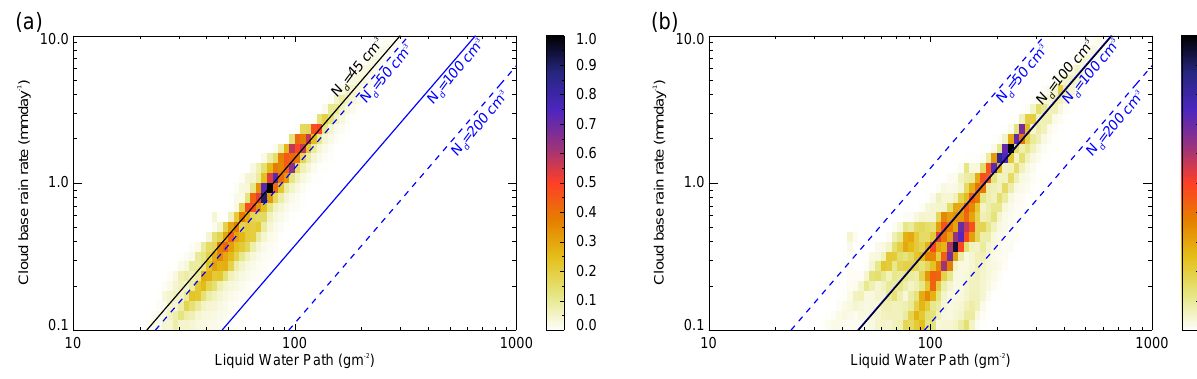
Fig. 7. Normalised histograms of liquid water path versus cloud base rain rate over the two-day period from a 1 ◦ region surrounding the Ron Brown, for the 1km control ( a ) and modified microphysics ( b ) simulations. The relationships derived by Comstock et al. (2004) for several values of cloud droplet number are shown in blue, with a fit to the data shown in